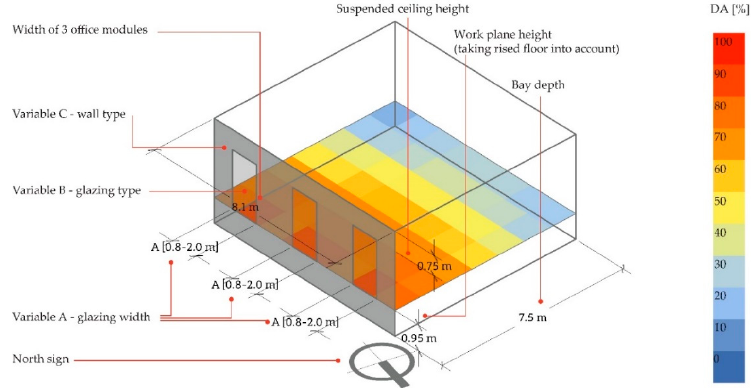
Figure 13. Variable and constant values of the chosen areas algorithmic model showing Daylight Autonomy zones.